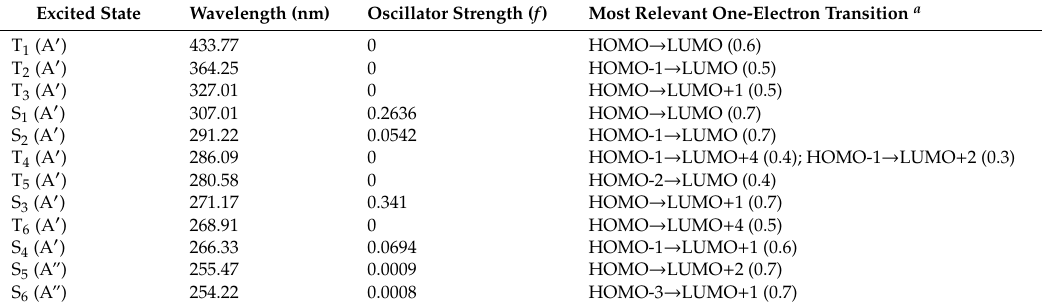
Figure 6. Simulated UV spectrum of thiabendazole ( trans conformer) as predicted by the performed TD-DFT / B3LYP / 6-311 ++ G(2d,2p) calculations. The stick spectrum presents the position of the calculated transitions and corresponding oscillator strengths. The band profile was generated using Gaussian bands with the heights proportional to the calculated oscillator strengths and an arbitrary width. Table3. ResultsoftheTD-DFT / B3LYP / 6-311 ++ g(2d,2p)calculationsforthiabendazole( trans conformer). Excited State Wavelength (nm) Oscillator Strength ( f